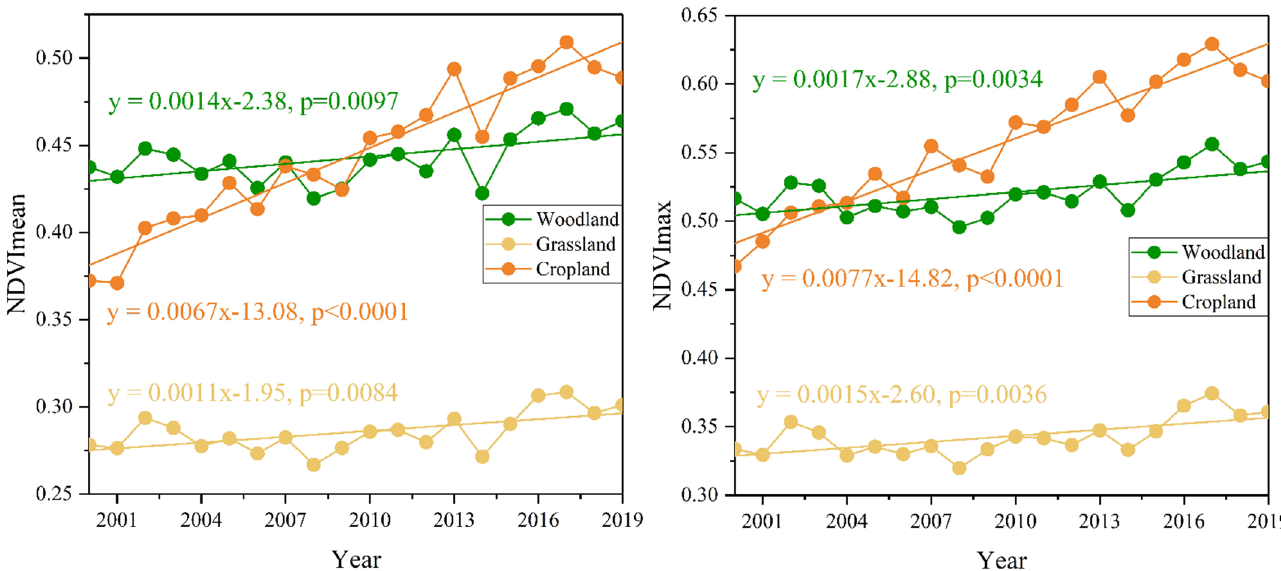
Figure 4. The average NDVI mean and NDVI max of the grid cells for every land use type in plant growing season for two decades (2000 − 2019).